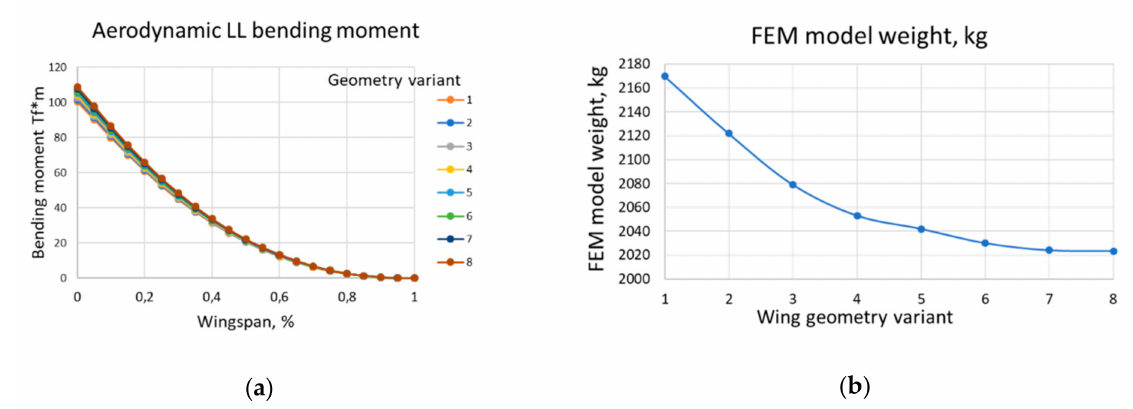
Figure 12. Bending moments ( a ) and mass of structure of frame of the regional aircraft ( b ).